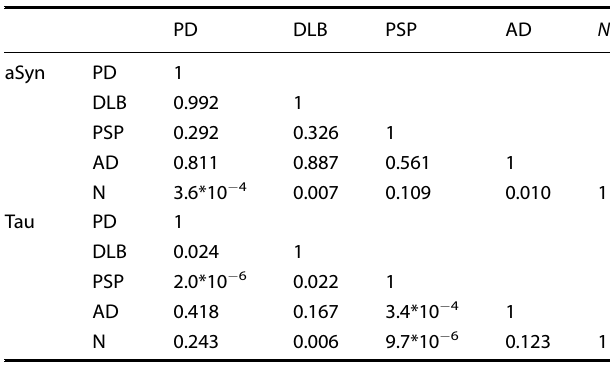
Table 2. P -values of two-sided Mann-Whitney U test for pairwise comparisons of measured aSyn and of Tau aggregate